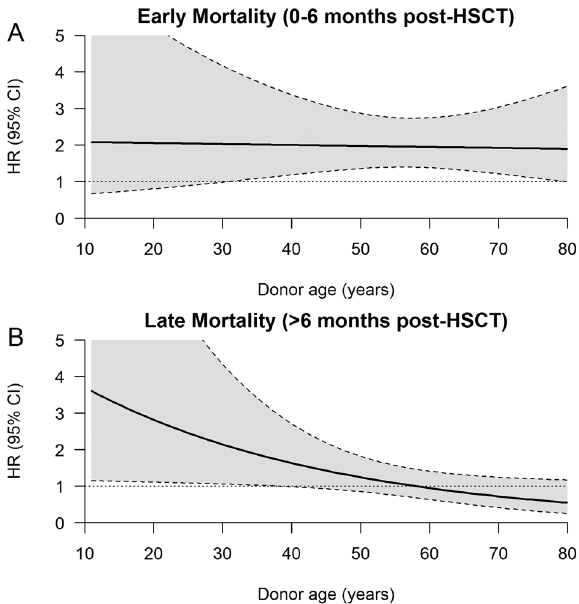
Fig. 4 Hazard ratio of mortality when comparing HD vs MSD donors of the same age. A HR for OS according to donor age comparison of haploidentical with sibling donor within 6 months ( B ) after 6